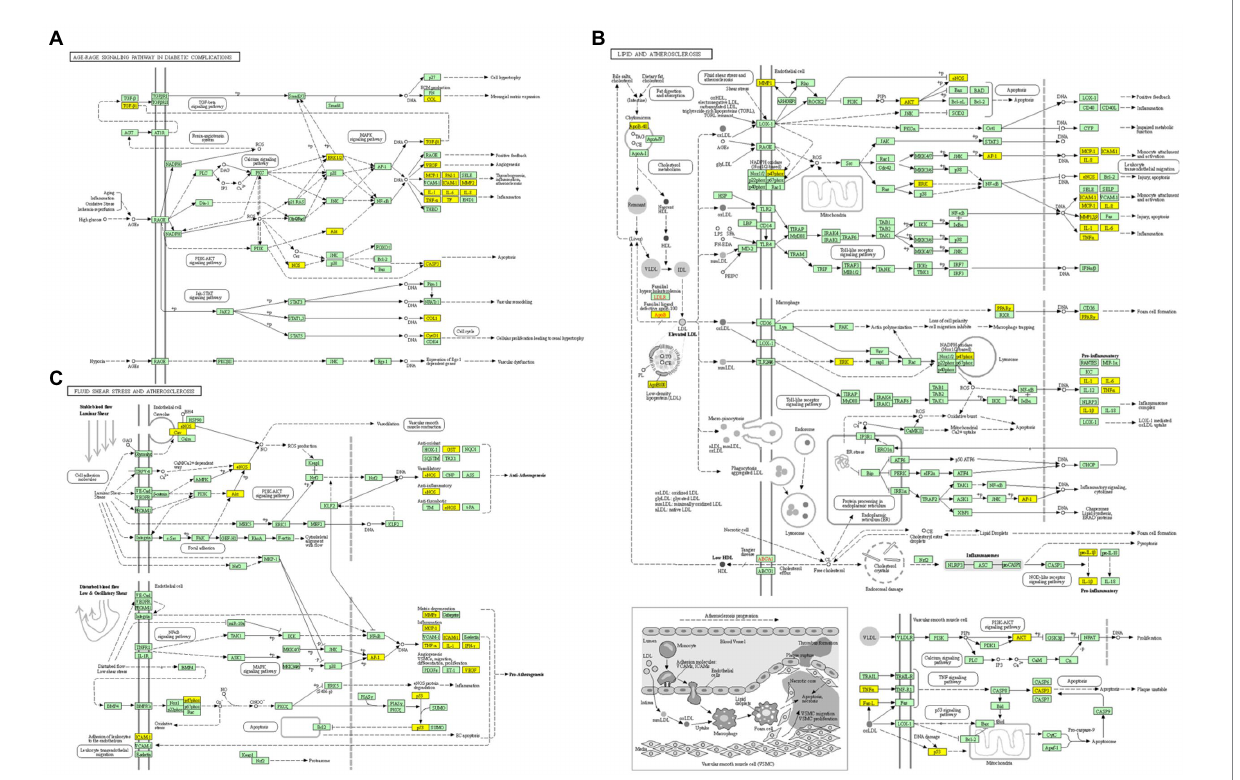
FIGURE 6 KEGG enrichment analysis pathway diagram. (A) The pathway map of AGE-RAGE signaling pathway in diabetic complications. (B) The pathway map of lipid and atherosclerosis. (C) The pathway map of fluid shear stress and atherosclerosis. The non-white targets in the pathway map are the intersection targets of ELJN and ISHL, while the yellow color is the possible targets present in the pathway as a result of KEGG enrichment